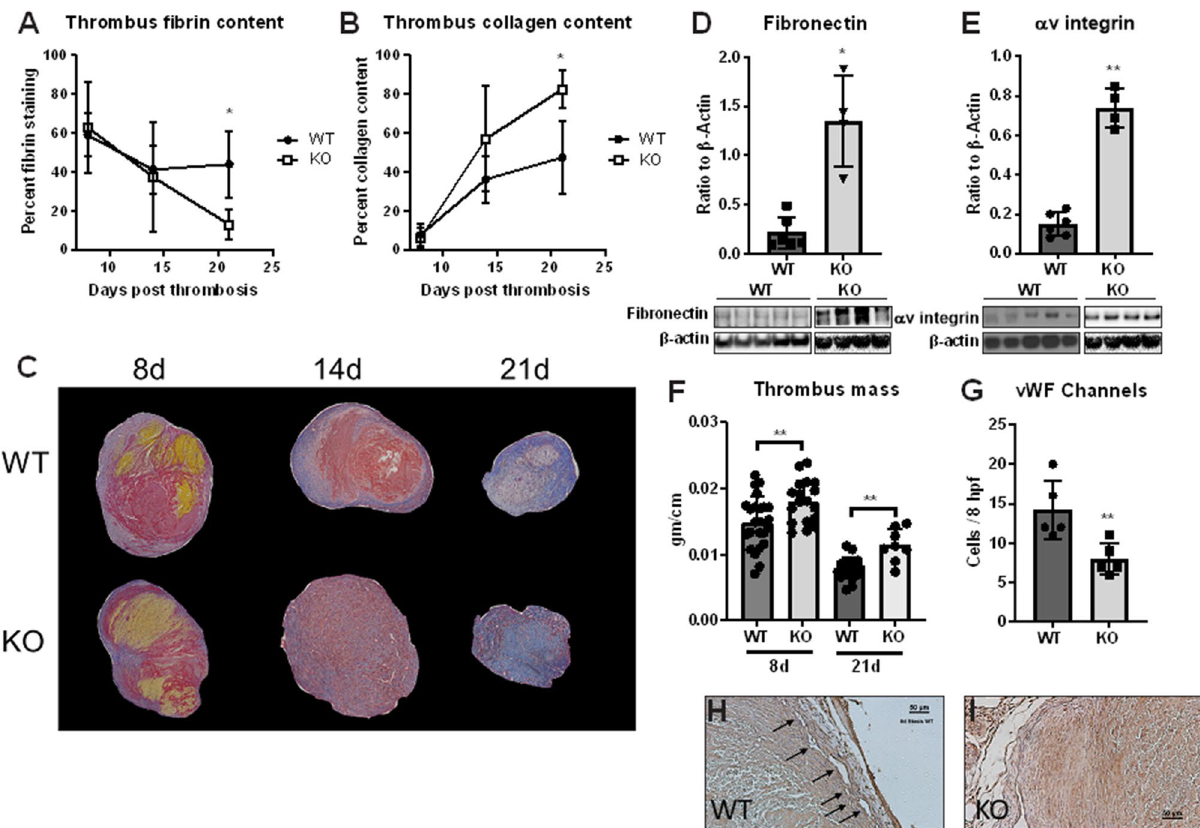
Figure 2. Loss of IL-6 signaling results in impaired thrombus resolution, increased collagen deposition and reduced recanalization. IL-6 −/− and WT mice underwent venous thrombosis via IVC ligation and thrombus evaluated for composition at 8, 14 and 21 days. Martius Scarlet and Blue trichrome staining was performed to determine relative fibrin ( A ) and collagen ( B ) content over time (each data point representative of ≥ 3 analyses). Representative mosaic photos of isolated thrombus without adjacent vein wall of WT and IL6 −/− shown in ( C ); red staining indicative of fibrin, yellow of erythrocytes and blue of collagen. Total thrombus lysate was evaluated at 8 days by western blotting for glycoprotein fibronectin ( D ) and receptor integrin αv (n = 4–6/group) ( E ) Gel blots cropped from different parts of the gel are presented, with white line separation. Thrombus resolution was quantified via measurements of thrombus weight and length at mid (8 days) and late (21 days) timepoints post thrombosis ( F ). Thrombus recanalization was quantified via presence of positively stained vWF channels within 8 hpf (n = 4–6/group) ( G ). Representative photomicrographs at 40 × of WT (left, arrows mark recanalization channels) and IL-6 −/− shown in H and I . All data presented as mean ± standard deviation. Normally